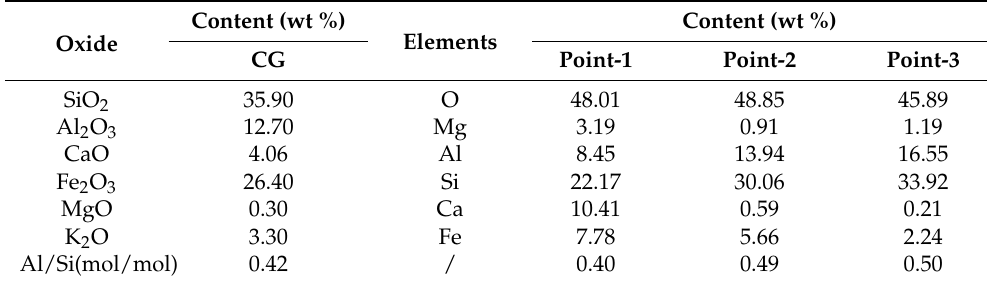
Table 2. XRF and EDS elemental analysis of the raw CG sample.